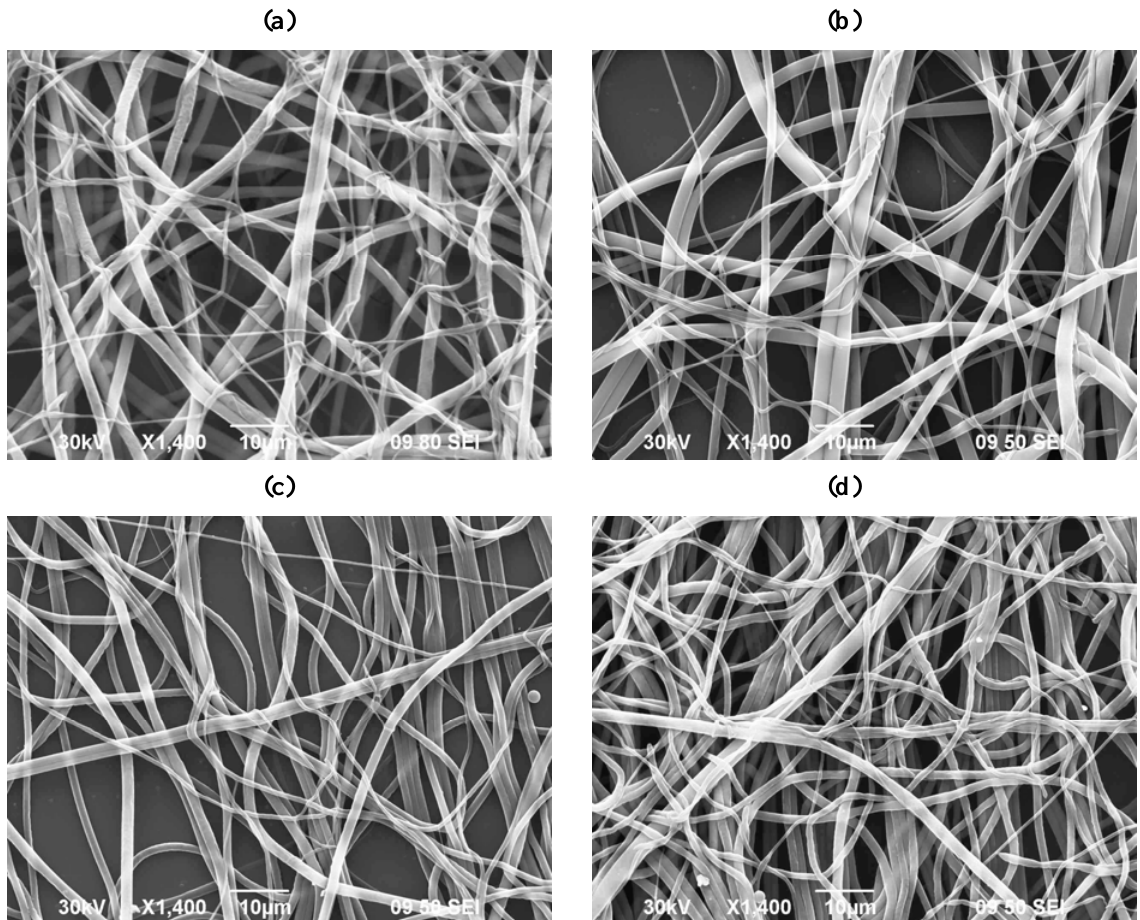
Figure 2. Fiber mat morphology. PLEY: ( a ) Non-crosslinked; ( b ) Crosslinked. PLO: ( c ) Non-crosslinked; ( d ) Crosslinked. All micrographs were obtained at 1400× magnification and 30 kV accelerating